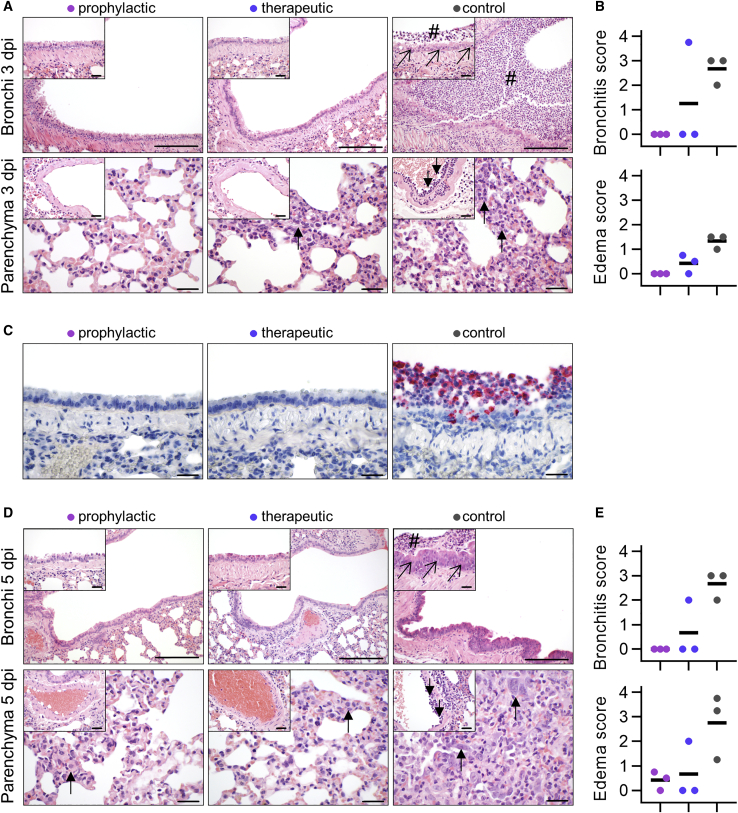
Histopathological Analysis of Hamsters after SARS-CoV-2 Infection(A) Histopathology of representative hematoxylin-and-eosin-stained, paraffin-embedded bronchi with inserted epithelium (top row) and lung parenchyma with inserted blood vessels (bottom row) at 3 dpi. Severe suppurative bronchitis with immune cell infiltration (hash symbol) is apparent only in the control-treated animals with necrosis of bronchial epithelial cells (diagonal arrows). Necro-suppurative interstitial pneumonia (upward arrows) with endothelialitis (downward arrows) is prominent in control-treated animals. Scale bars, 200 μm in the bronchus overview, 50 μm in all others.(B) Bronchitis and edema score at 3 dpi. Bars indicate the mean.(C) Detection of viral RNA (red) using in situ hybridization of representative bronchial epithelium present only in the control group. Scale bars, 50 μm.(D) Histopathology of representative lung sections from areas comparable with (A) at 5 dpi. Staining of bronchi of control-treated animals showed marked bronchial hyperplasia with hyperplasia of epithelial cells (diagonal arrow) and still existing bronchitis (hash symbol), absent in all prophylactically treated and in 2/3 therapeutically treated animals (top row). Lung parenchyma staining of control-treated animals showed severe interstitial pneumonia with marked type II alveolar epithelial cell hyperplasia and endothelialitis (insets, downward arrows). Compared with control-treated animals, prophylactically treated animals showed only mild signs of interstitial pneumonia with mild type II alveolar epithelial cell hyperplasia (upward arrow), whereas therapeutically treated animals showed a more heterogeneous picture, with 1/3 animals showing no signs of lung pathology, 1/3 animals showing only mild signs of interstitial pneumonia, and 1/3 animals showing moderate multifocal interstitial pneumonia. Scale bars, 200 μm in the bronchus overview, 50 μm in all others.(E) Bronchitis and edema score at 5 dpi. Bars indicate the mean.See also Figure 5 and Table S6.